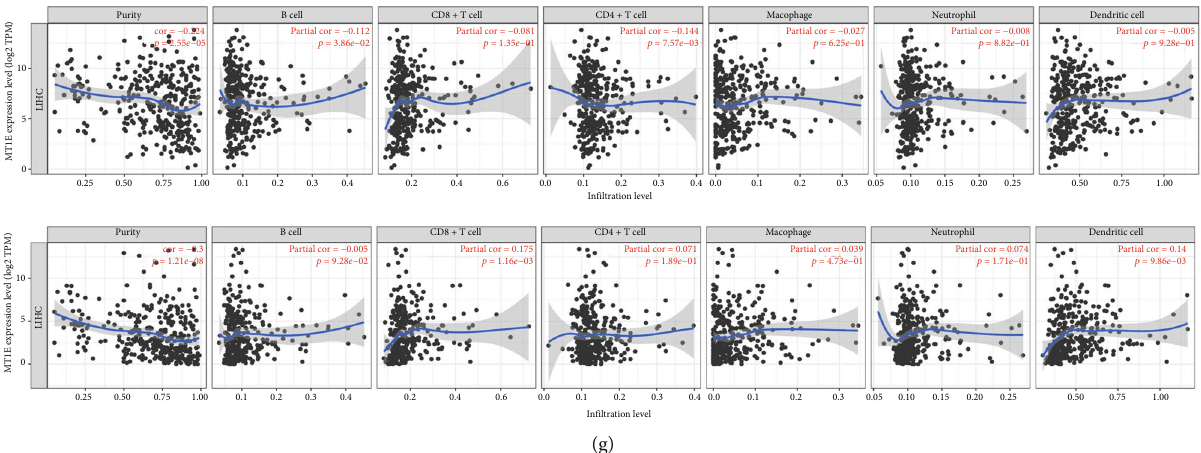
Figure 6: MT1E and MT1M expression levels in HCC based on UALCAN portal analysis and their association with immune cell in fi ltration. (a) Boxplot showing the overall comparison of MT1E expression between tumor and normal samples across multiple cancer types in the TCGA database. (b) The expression of MT1E in normal tissues compared with HCC tissues. (c) The comparison of MT1E expression in normal tissues compared with HCC tissues from di ff erent tumor grade (grades 1 to 4), age (21-40, 41-60, 61-80, and 81-100 years old), gender (male and female), and race (Caucasian, African-American, or Asian ethnicity). (d) Boxplot showing the overall comparison of MT1M expression between tumor and normal samples across multiple cancer types in the TCGA database. (e) The expression of MT1M in normal tissues compared with HCC tissues. (f) The comparison of MT1M expression in normal tissues compared with HCC tissues from di ff erent tumor grade (grades 1 to 4), age (21-40, 41-60, 61-80, and 81-100 years old), gender (male and female), and race (Caucasian, African-American, or Asian ethnicity). (g) Correlation of MT1E and MT1M expression with immune in fi ltration level in HCC via the TIMER database. Both MT1E and MT1M expression were signi fi cantly correlated with the in fi ltration levels of B cells, CD8 + T cells, CD4 + T cells, macrophages, neutrophils, and dendritic cells in